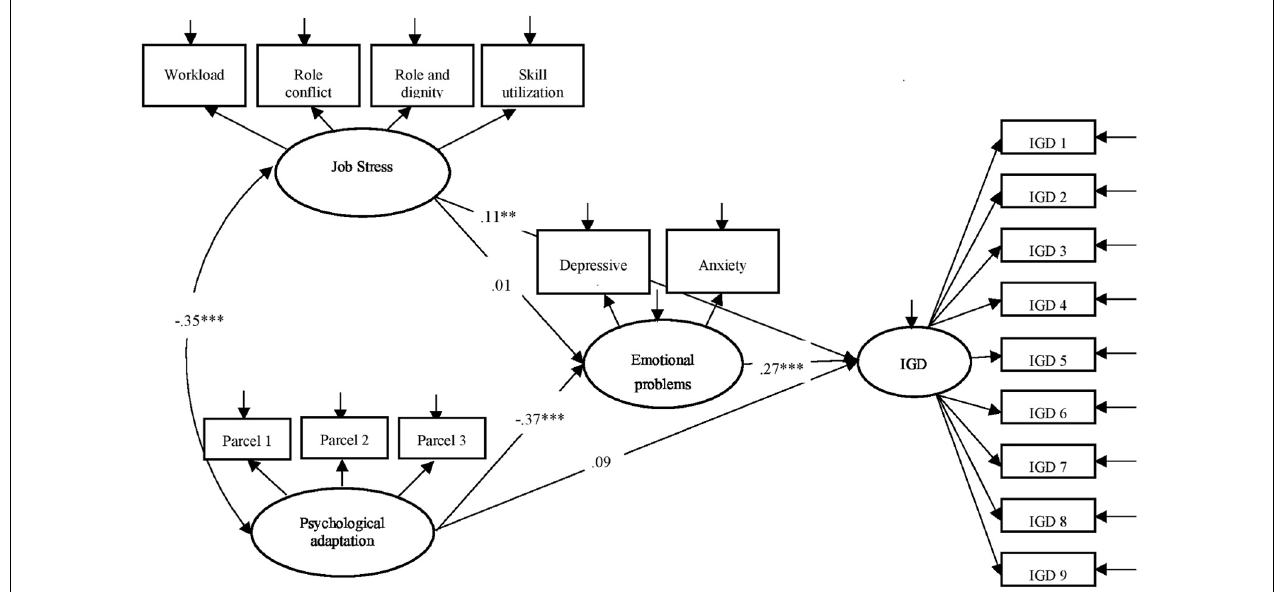
FIGURE 1 | The proposed meditation model with standardized path